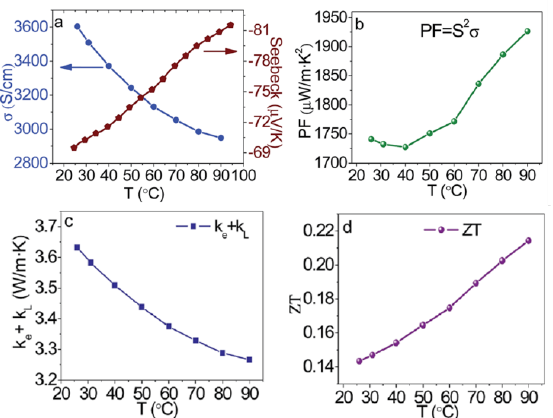
Figure 15. Electrical conductivity, Seebeck coefficient, power factor, calculated thermal conductivity, and ZT at different temperatures for the C 6 H 4 NH 2 CuBr 2 I. Reproduced with permission [35]. Copyright 2017, Royal Society of Chemistry.